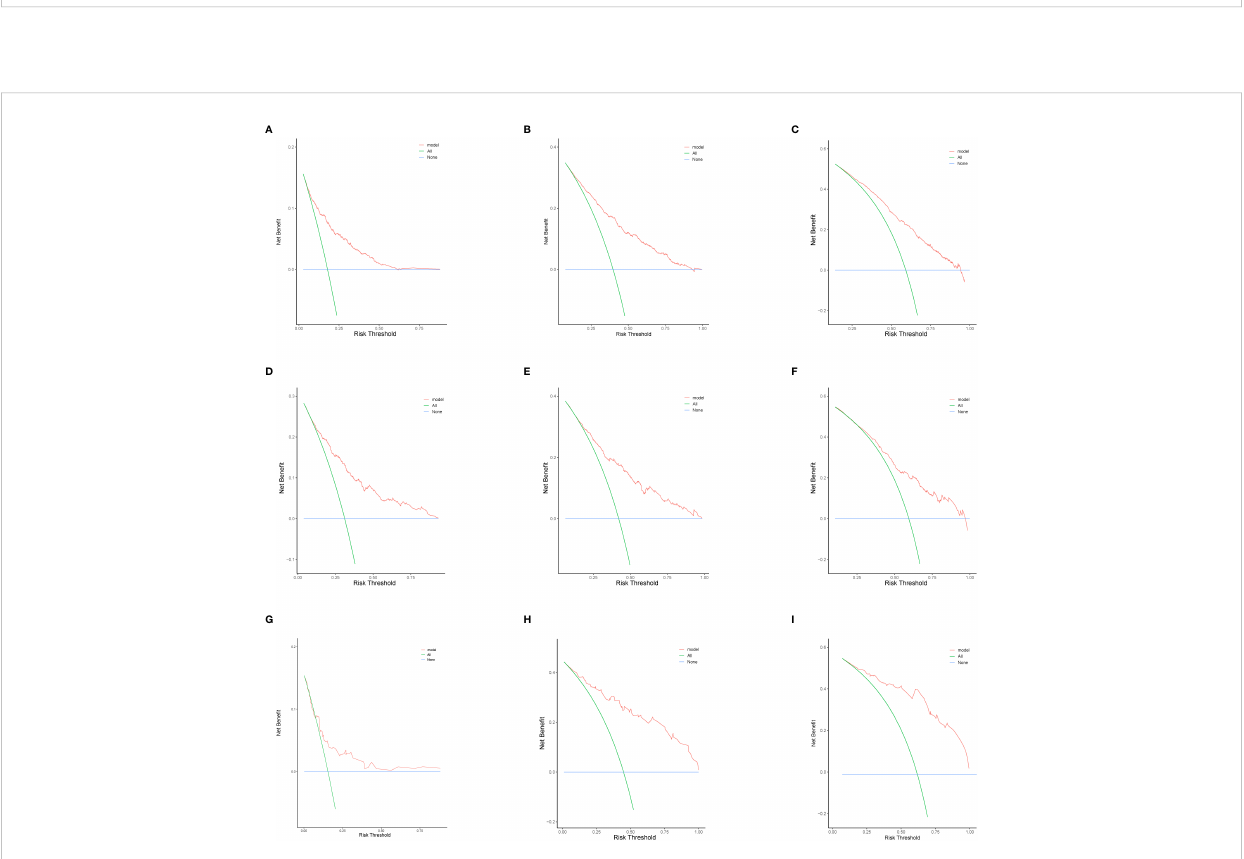
FIGURE 5 The decision curve analysis of nomograms to predict 1-, 2-, and 3-year overall survival in the training cohort (A-C) validation cohort (D – F) , and testing cohort (G – I)